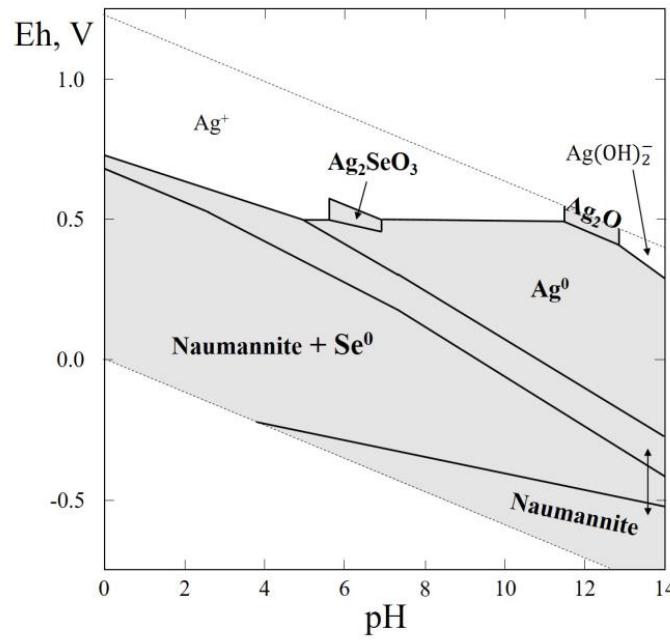
Figure 10. Eh–pH diagram of the OHSeAg (Ag–Se–H 2 O) system at 25 ◦ C and the activities of the Figure 10. Eh – pH diagram of the OHSeAg (Ag-Se-H 2 O) system at 25 °C and the activities of the components: a Σ Se = 10 − 4 , a Σ Ag = 10 − 5 components: a ΣSe = 10 − 4 , a ΣAg = 10 − 5 .